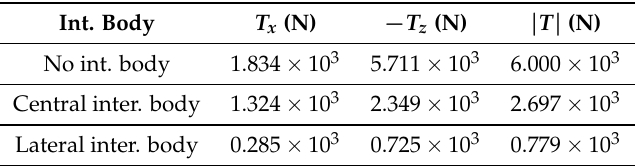
Figure 26. Time evolution of the tension force of the wire at the fairlead for three different floating body towing systems. Table 4. Results at equilibrium of the tension at the towed body’s end of the cable for floating body towing systems with different intermediate body